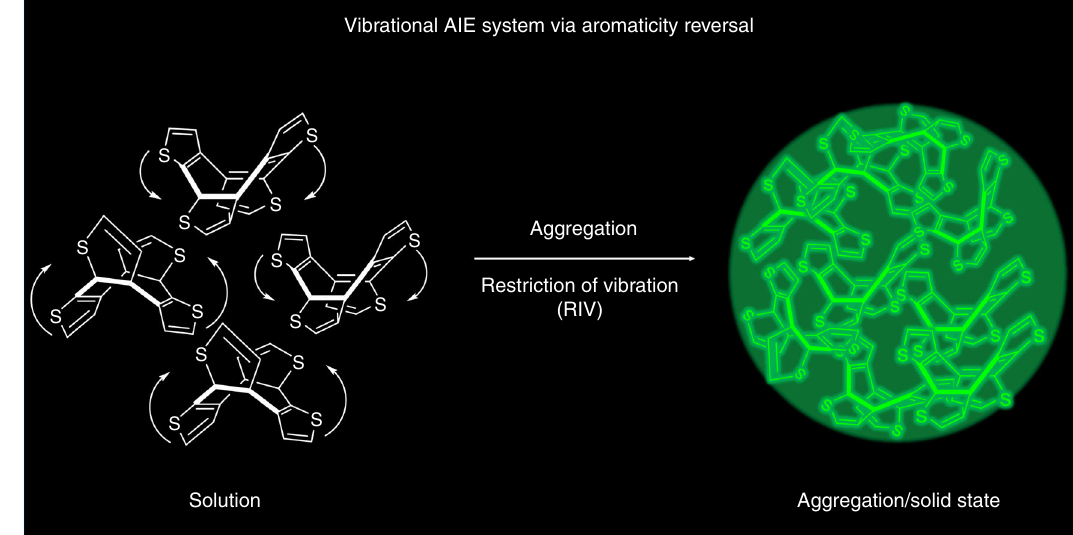
Fig. 1 Schematic diagram illustrating the AIE process of COTh system. In solution, the active vibration of COTh upon excitation quench the emission, while in the aggregates or solid state, the restriction of vibration light up the bright green